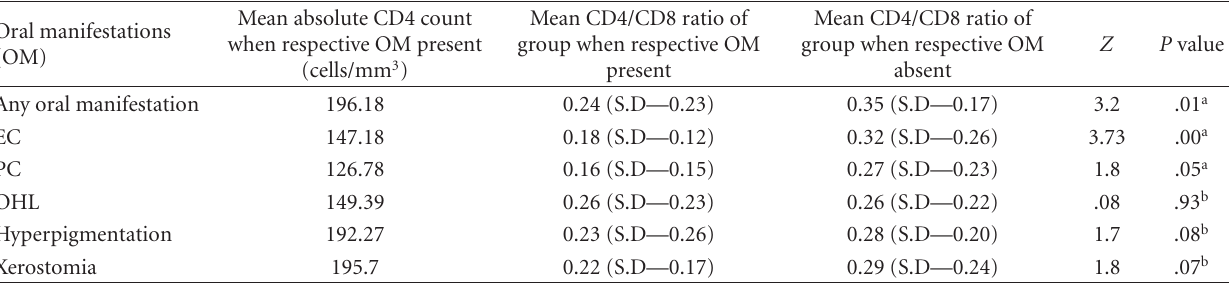
Table 4: Mean CD4/CD8 ratio and their association with presence or absence of oral manifestations.